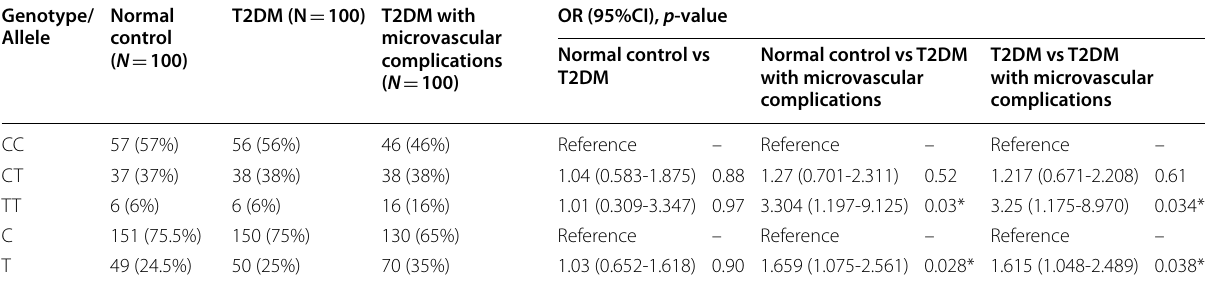
Table 1 Comparison of genotypes and allele frequency of ALR2 between normal control, T2DM and T2DM with microvascular complication